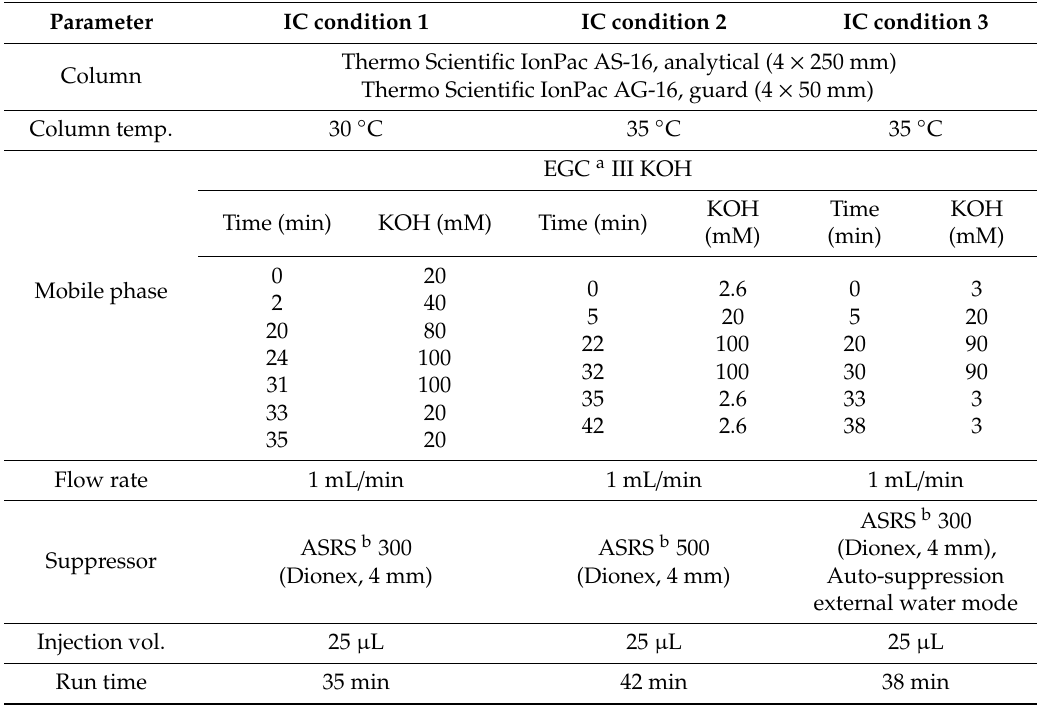
Table 1. Technical details of the three ion chromatography (IC)